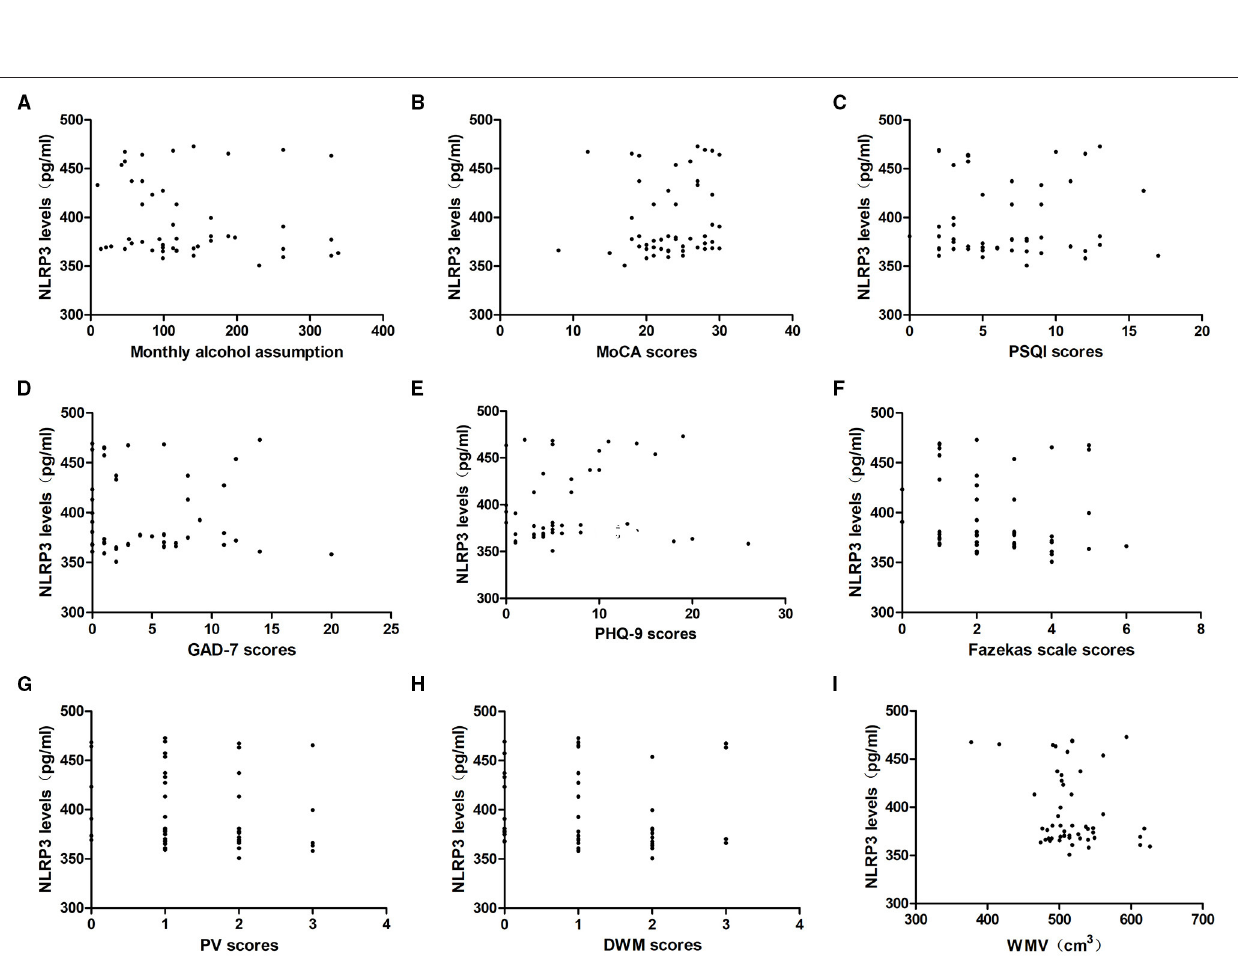
Frontiers in Psychiatry |